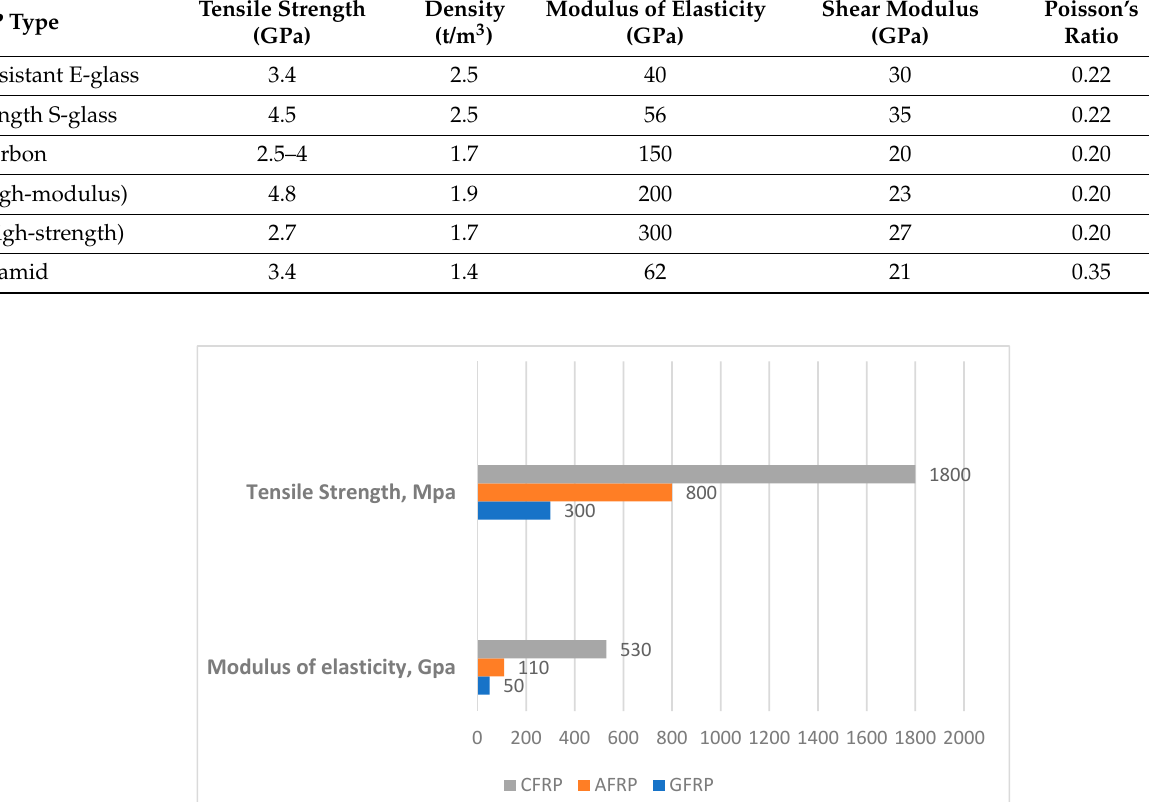
Figure 4. FRP pole.